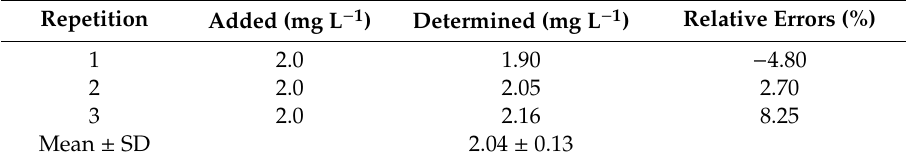
Table 2. Results for the determination of SEA in pasteurized milk samples by impedimetric proposed